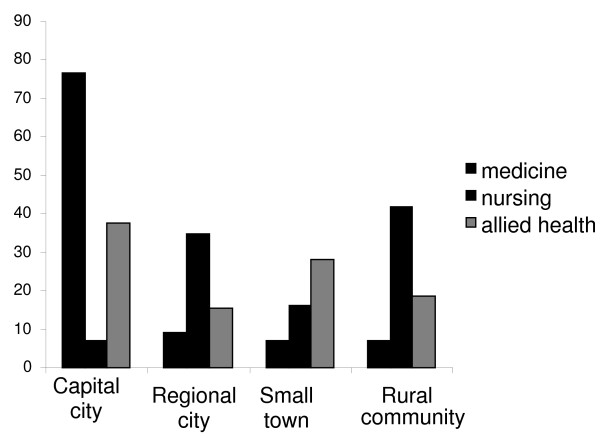
Student background by discipline.